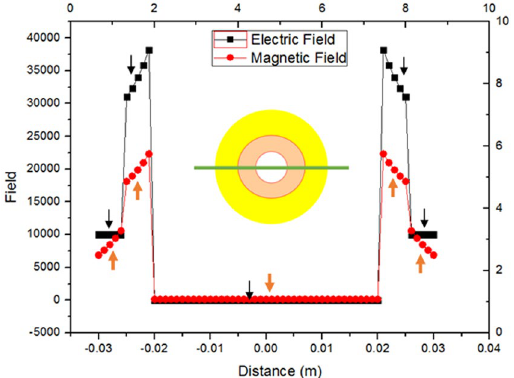
Figure 5. The distributions of the electric field and induced magnetic field in the center line (y = 0, z = 0, green line in insert). The five black segments (indicated by black arrows) are the distributions of the electric field and the five red segments (indicated by red arrows) are the distributions of the induced magnetic field. The electric and the induced magnetic field are not continuous on the boundaries x = ± 0.025 m, x = ± 0.020 m, x = ± 0.010 m. The magnetic fields are 30000 times actual magnetic